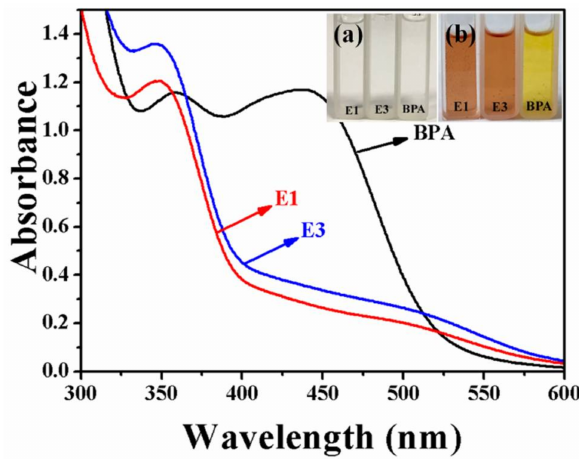
Figure 4. Visual color change before (a) and after (b) coupling reactions between the estrogens E1, E3 and BPA; and the UV–Vis spectra of the corresponding azo dyes.